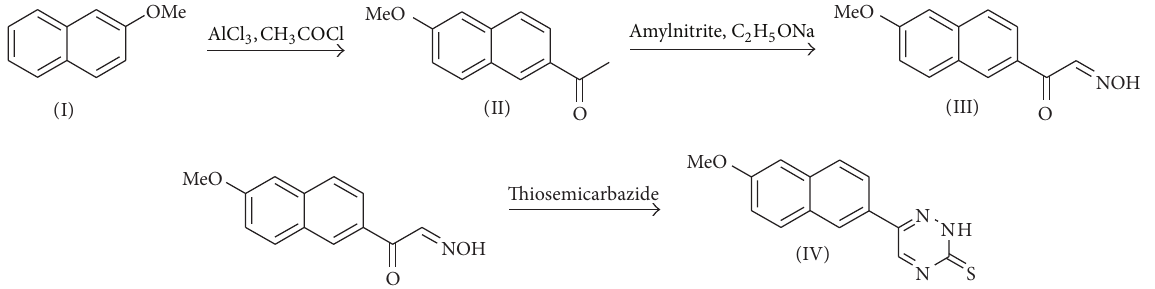
Figure 1: Synthesis of 6-(2-methoxynaphthyl)-2,3-dihydro-1,2,4-triazine-3-thione